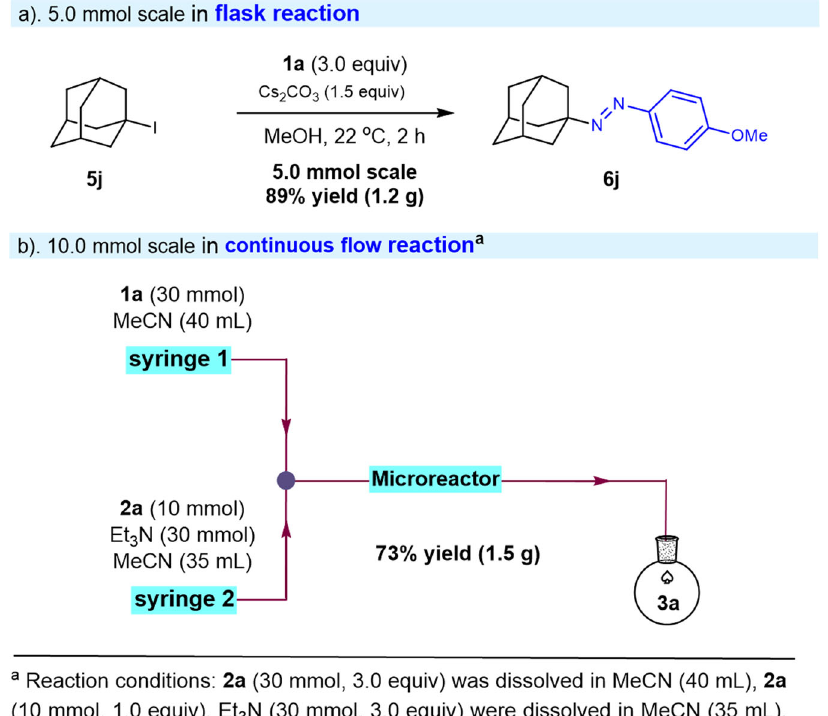
Fig. 5 | Bigger scale reaction. a 5.0mmol scale in fl ask conditions. b 10.0mmol scale in fl ow conditions.